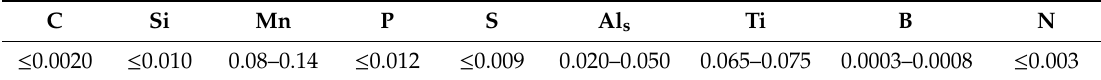
Table 1. The standard for judging the chemical composition of IF steel,